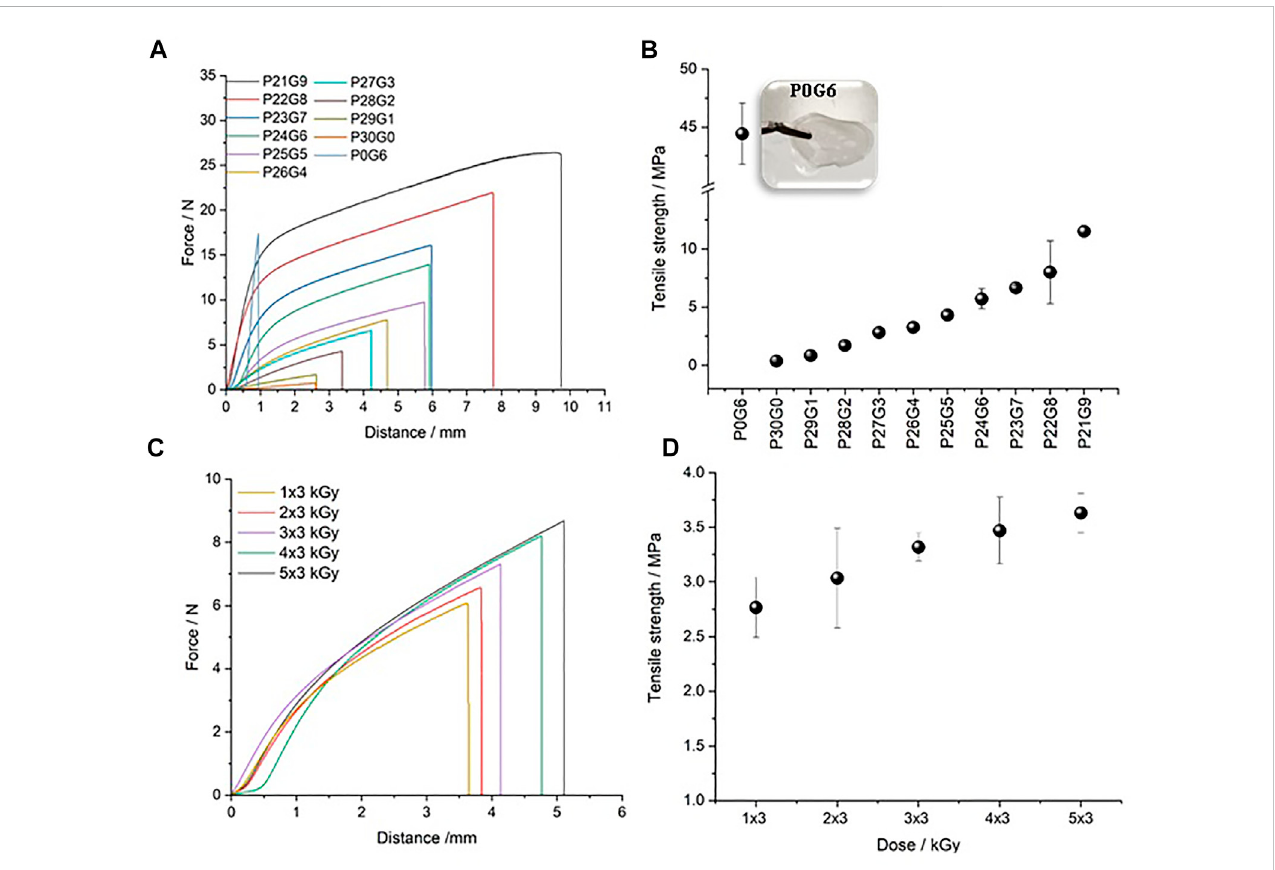
FIGURE 2 Tensile test and tensile strength: (A,B) different PEGDA/gelatin ratios of hybrid hydrogels irradiated with 6 kGy and (C,D) P26G4 hydrogel irradiated with different electron irradiation doses. Error bars indicate the standard deviation.